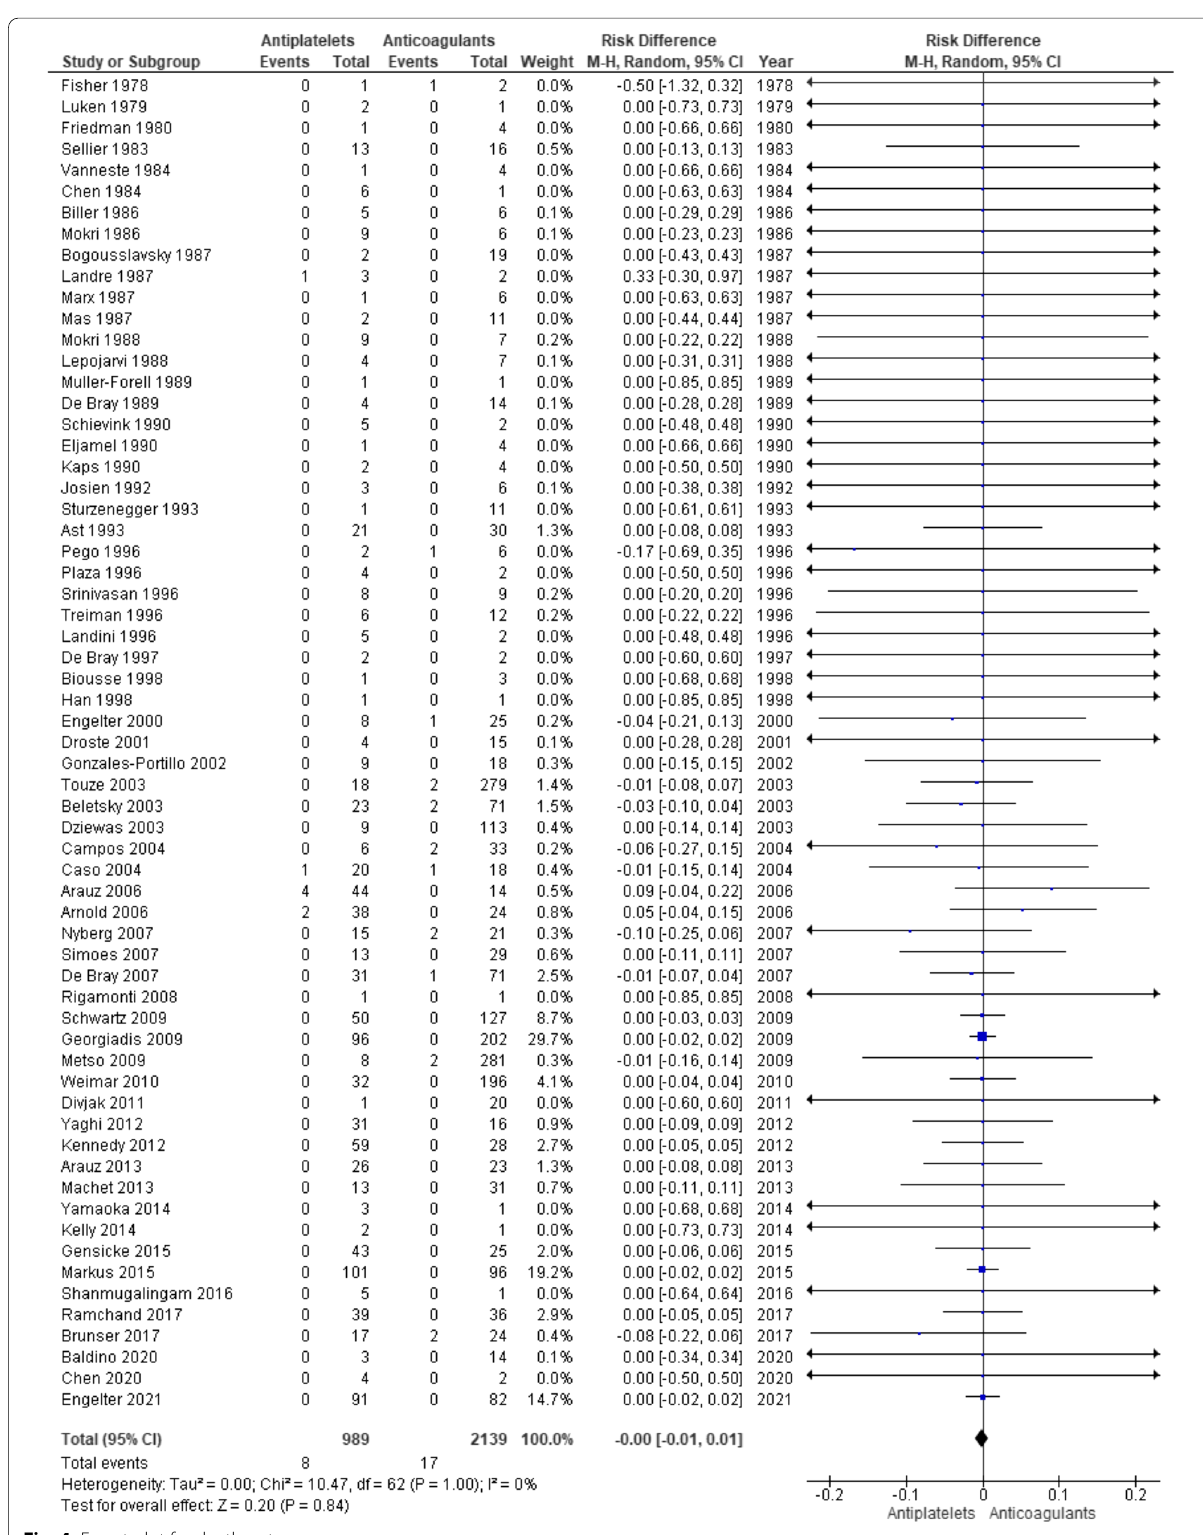
Fig. 4 Forest plot for death